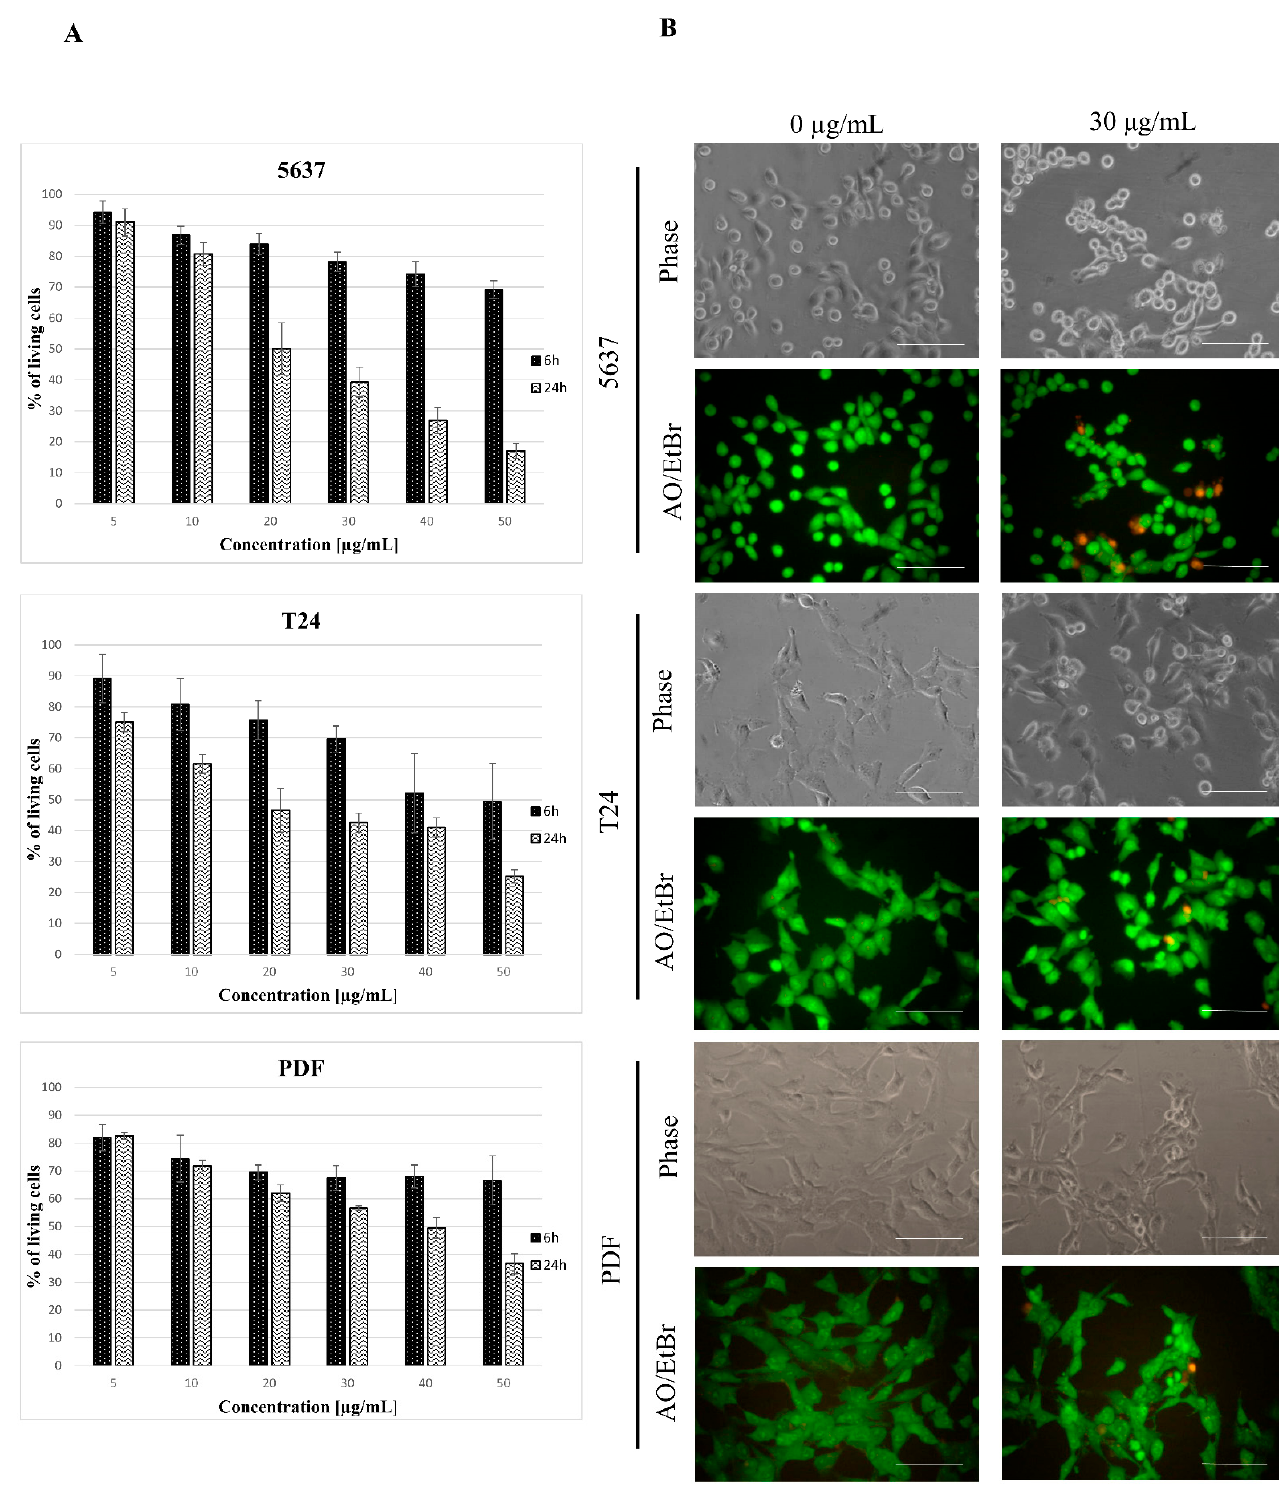
Figure 5. Kinetics of star polymer action on human bladder cancer cell lines and human dermal fibroblasts (PDF). ( A ) Cytotoxicity dynamics of star polymer for 5637 and T24 cancer cell lines and PDF after 6 and 24 h of treatment. ( B ) Cells’ morphology after 6 h of star polymer treatment at the concentration 30 µg/mL. Cells were double stained with acridine orange/ethidium bromide (AO/EtBr) in order to distinguish the cell death type. Scale bars represent 100 µm.